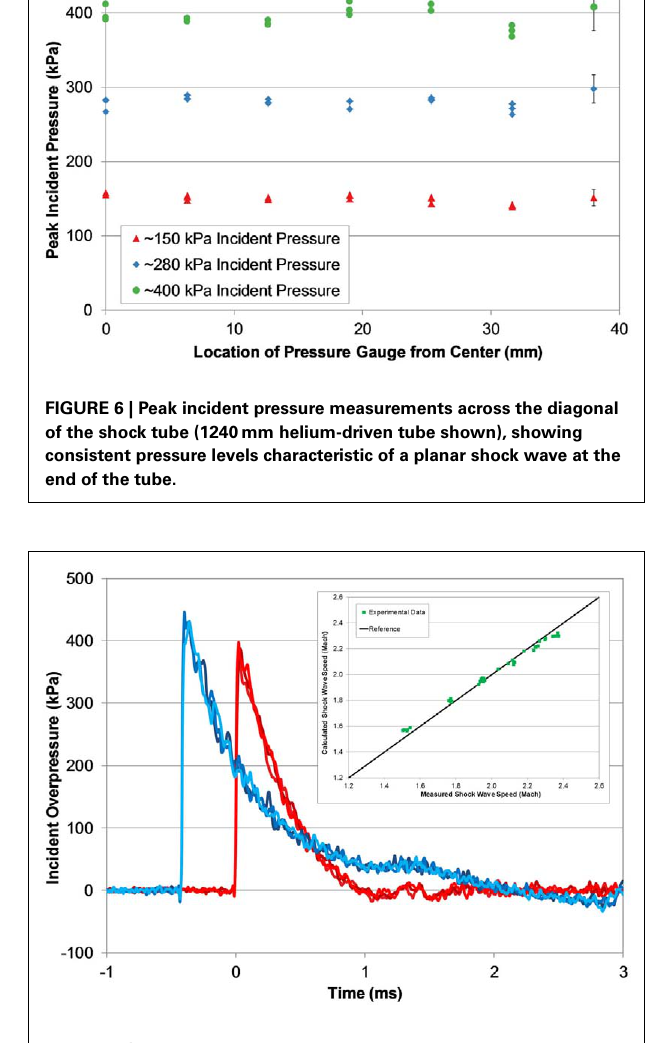
IN VITRO RECEIVER